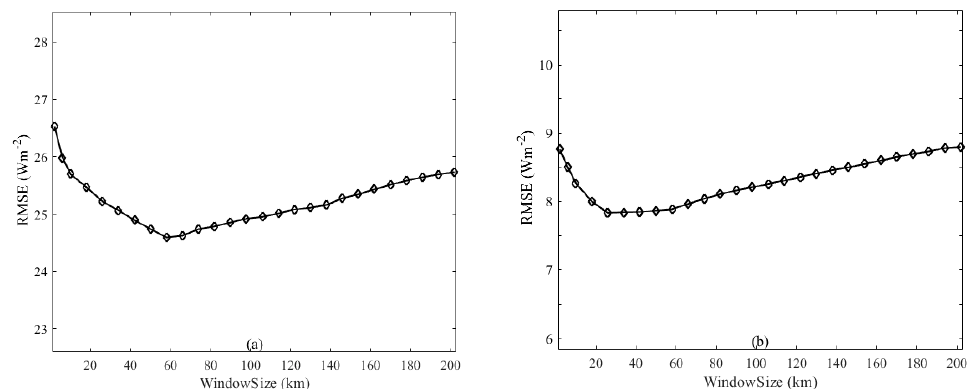
Figure 5. Impact of window size on the evaluation results of monthly mean estimated R S data from the RF method against ground measurements from CDC/CMA from February to May 2016. ( a ) Daily R S ; ( b ) Monthly R S .